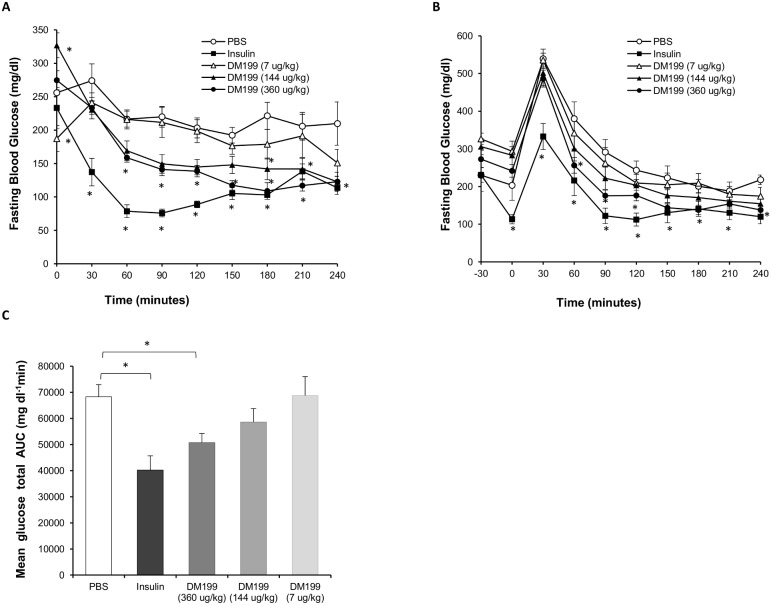
The effect of DM199 on fasting blood glucose and OGTT in db/db mice.(A) Blood glucose levels were measured in overnight-fasted female db/db mice (n = 9–10 per group) just prior to (t = 0 min) s.c. administration of PBS (Control), Insulin (5 U/kg) or DM199 (7, 144 or 360 µg/kg), and subsequently every 30 min over a 240 minute period. (B) After 7 days, the same cohorts of mice were fasted overnight, injected with test substances as in (A), and after 30 minutes, orally gavaged with 2 g/kg of glucose solution. Blood glucose was measured just prior to s.c. administration and oral gavage, and subsequently at 30 min intervals over a 240 minute period. (C) Mean glucose total AUC was computed from data in (B). Data are presented as the mean ± SEM. *p<0.05 vs. control.